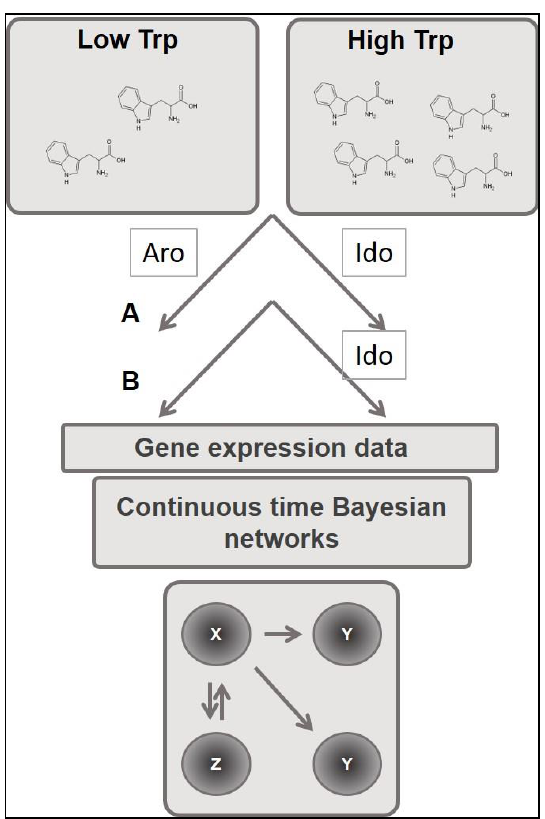
Figure 2. Experimental setting for model construction. A, wild type fungal strain was exposed to different concentrations of Trp (Low or High). B, ∆ aroH fungal strain exposed to different concentration of Trp (Low or High). X, Y, Z represent generical networks that will be eventually generated in the A and B conditions.